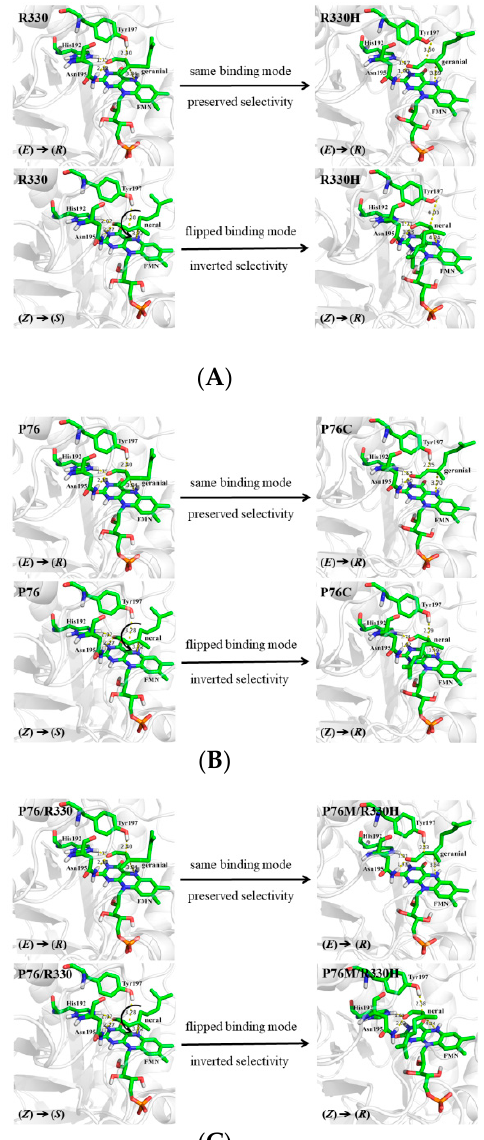
Figure 4. The binding modes of citral isomers in OYE2y and its variants R330H ( A ), P76C ( B ), and P76M/R330H ( C ) leading to either ( R )- or ( S )-citronellal. The catalytic residues H192, N195, Y197, and the prosthetic group FMN were depicted. Green, carbon atom; blue, nitrogen atom; tangerine, oxygen atom; white, hydrogen atom; orange, phosphorus atom.